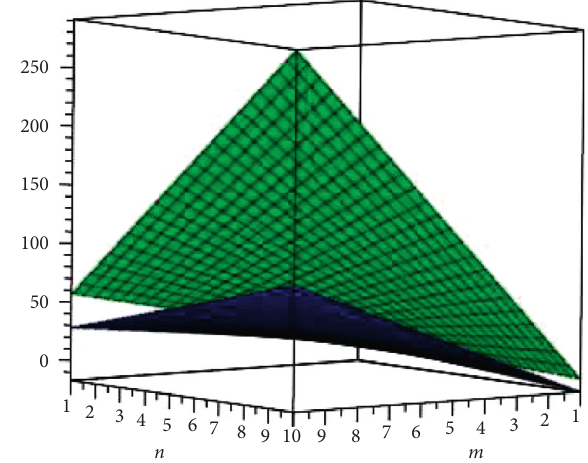
Figure 10: Graph for α � 28 2 ( nm − n ) + 12 2 ( mn − m ) + 2 . 8 2 ( mn − m ) + 6 n ( 4 n − 6 ) 2 + 8 2 m ( 3 n − 4 ) 2 ≤ χ − 4 ) 2 .